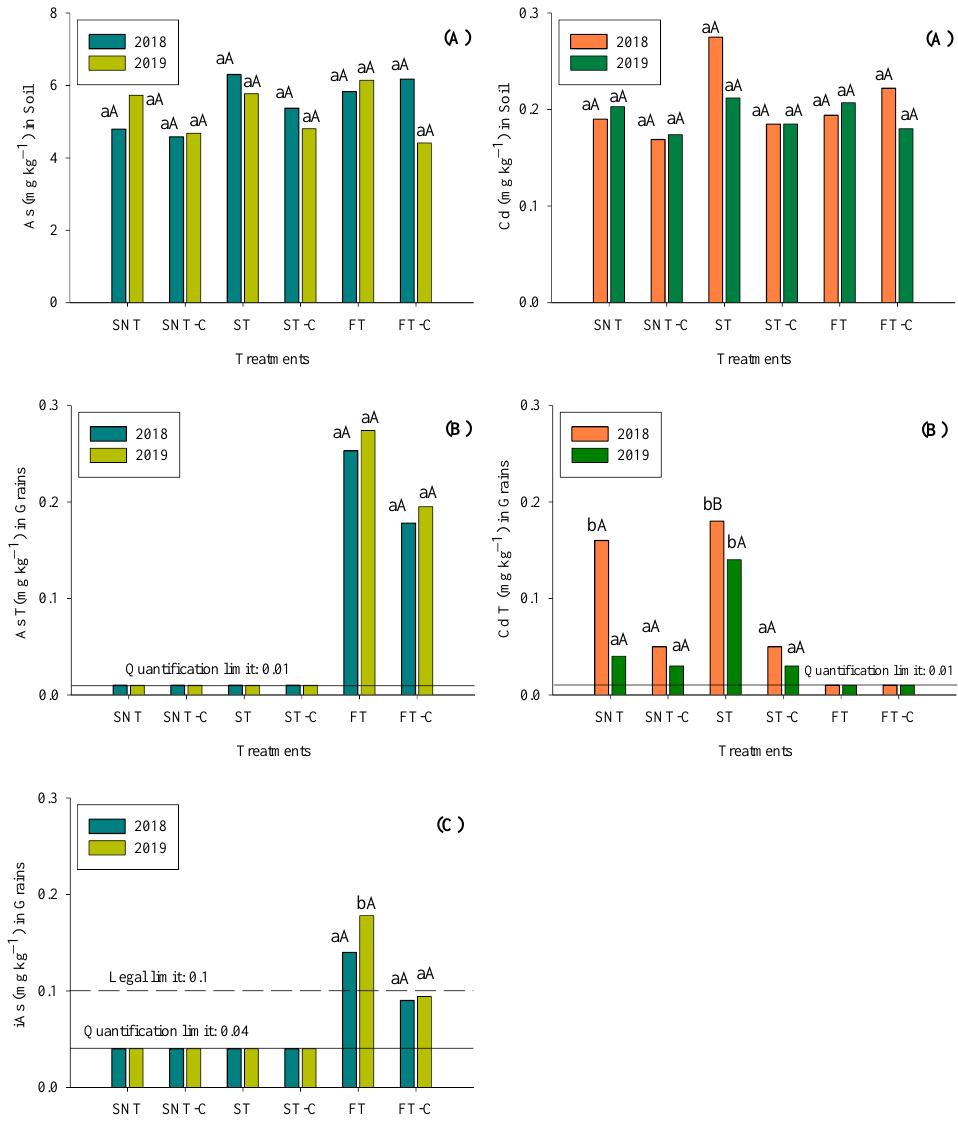
Figure 2. Medium-term effects of different management systems on concentrations of As and Cd in the soils ( A ), in the rice grains ( B ) and on concentrations of Inorganic As (iAs) in the rice grains ( C ). Different letters indicate differences ( p < 0.05) between treatments in the same year (lower case letters) and between years within the same treatment (upper case letters). Note: the concentrations of organic fractions of As were always below the quantification limit (0.05 mg kg −1 ). Unlike in soil, the management systems had significant effects on total As and Cd concentration in rice grains (Figure 2B). Thus, whereas As concentrations were 0.253 and 0.274 mg kg −1 under FT in 2018 and 2019, respectively, and 0.178 and 0.195 mg kg −1 under FT-C in 2018 and 2019, respectively, when sprinkler irrigation was used, the values were below the quantification limit (<0.01 mg kg −1 ), regardless of treatment and year. Similar results had been indicated by several authors (e.g., [29,60]) who indicated that under